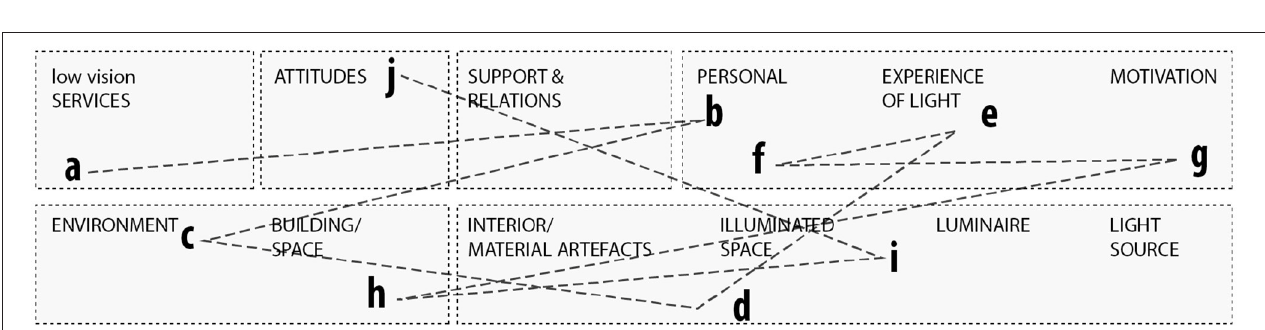
FIGURE 3 | Mapping of the trajectory of the implicit and explicit sequences of the assessment in the home environment placed in relation to extended ICF